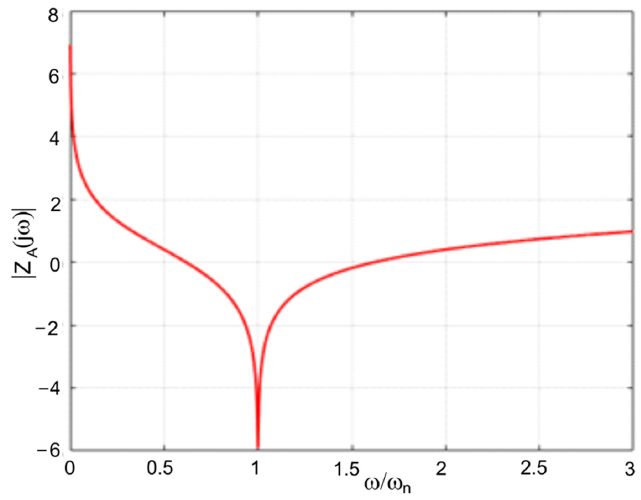
Figure 5. Characteristics of the HAC impedance amplitude.